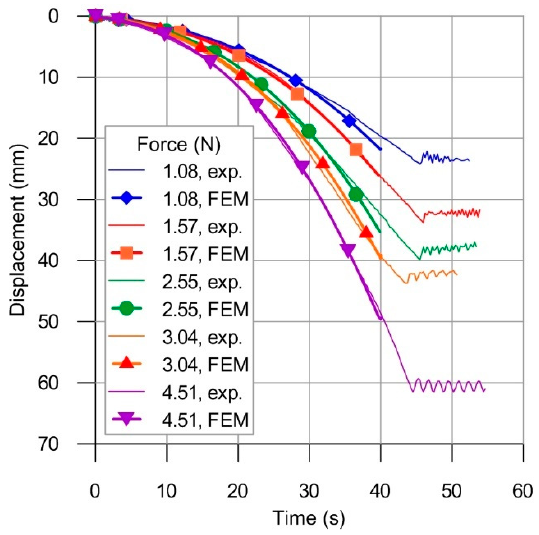
Table 2. The Johnson–Cook material model parameters.